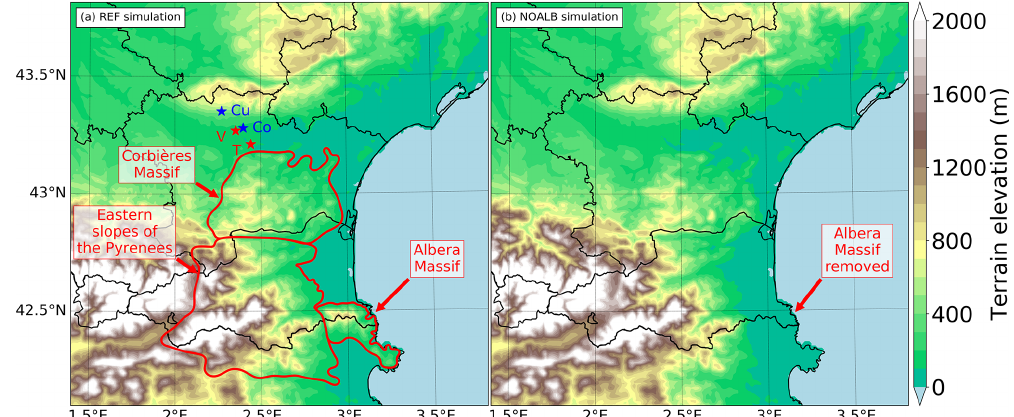
Figure 2. Orography of the south Languedoc-Roussillon including the Aude department in the simulations (a) REF and (b) NOALB, in which the Albera Massif is removed. Solid black lines indicate French departments and country borders. Stars indicate towns which were affected by the HPE: “V” is Villegailhenc, “T” is Trèbes, “Cu” is Cuxac-Cabardès, and “Co” is Conques-sur-Orbiel. Red contours indicate mountain